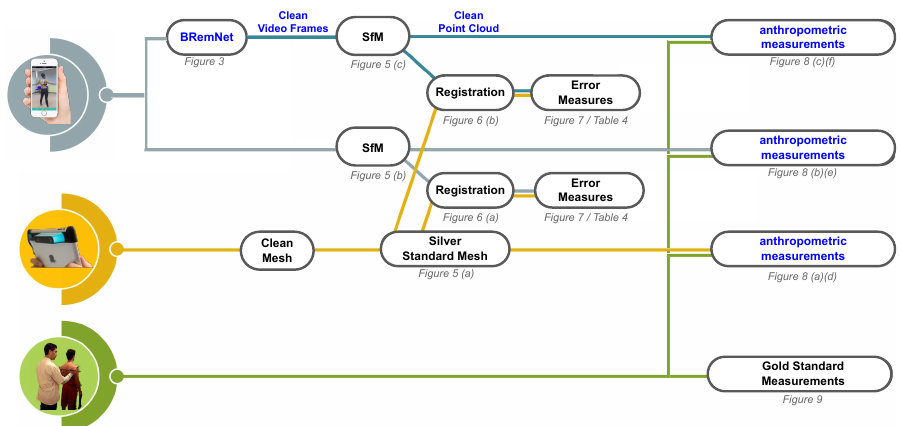
Figure 1. Overview of workflow. Inputs: Raw video in gray, LiDAR-Scanner in yellow, and Classical anthropometry in